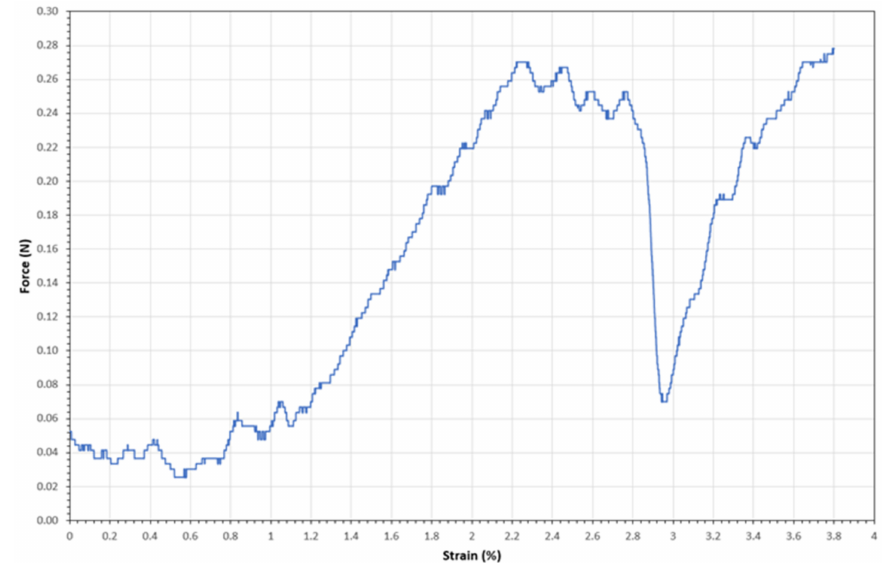
Figure 8. Typical tensile test curve on one of the